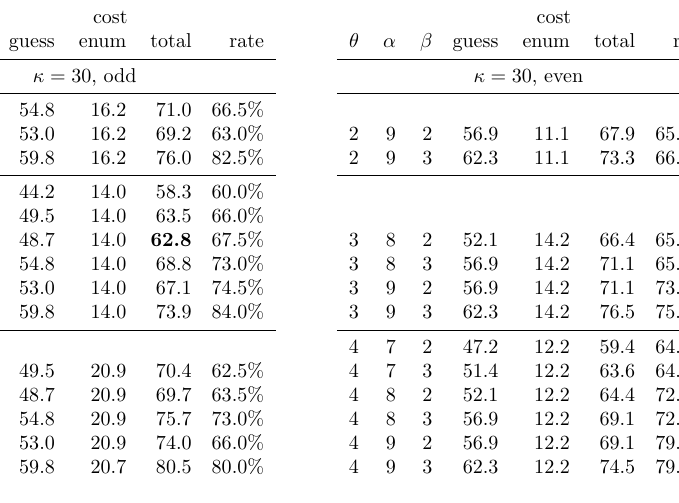
Table 11: Experimental results for Kyber parameters and κ = 30 ( ρ 0 = 1 . 7% , ρ 1 = 0 . 1%). For details see Table